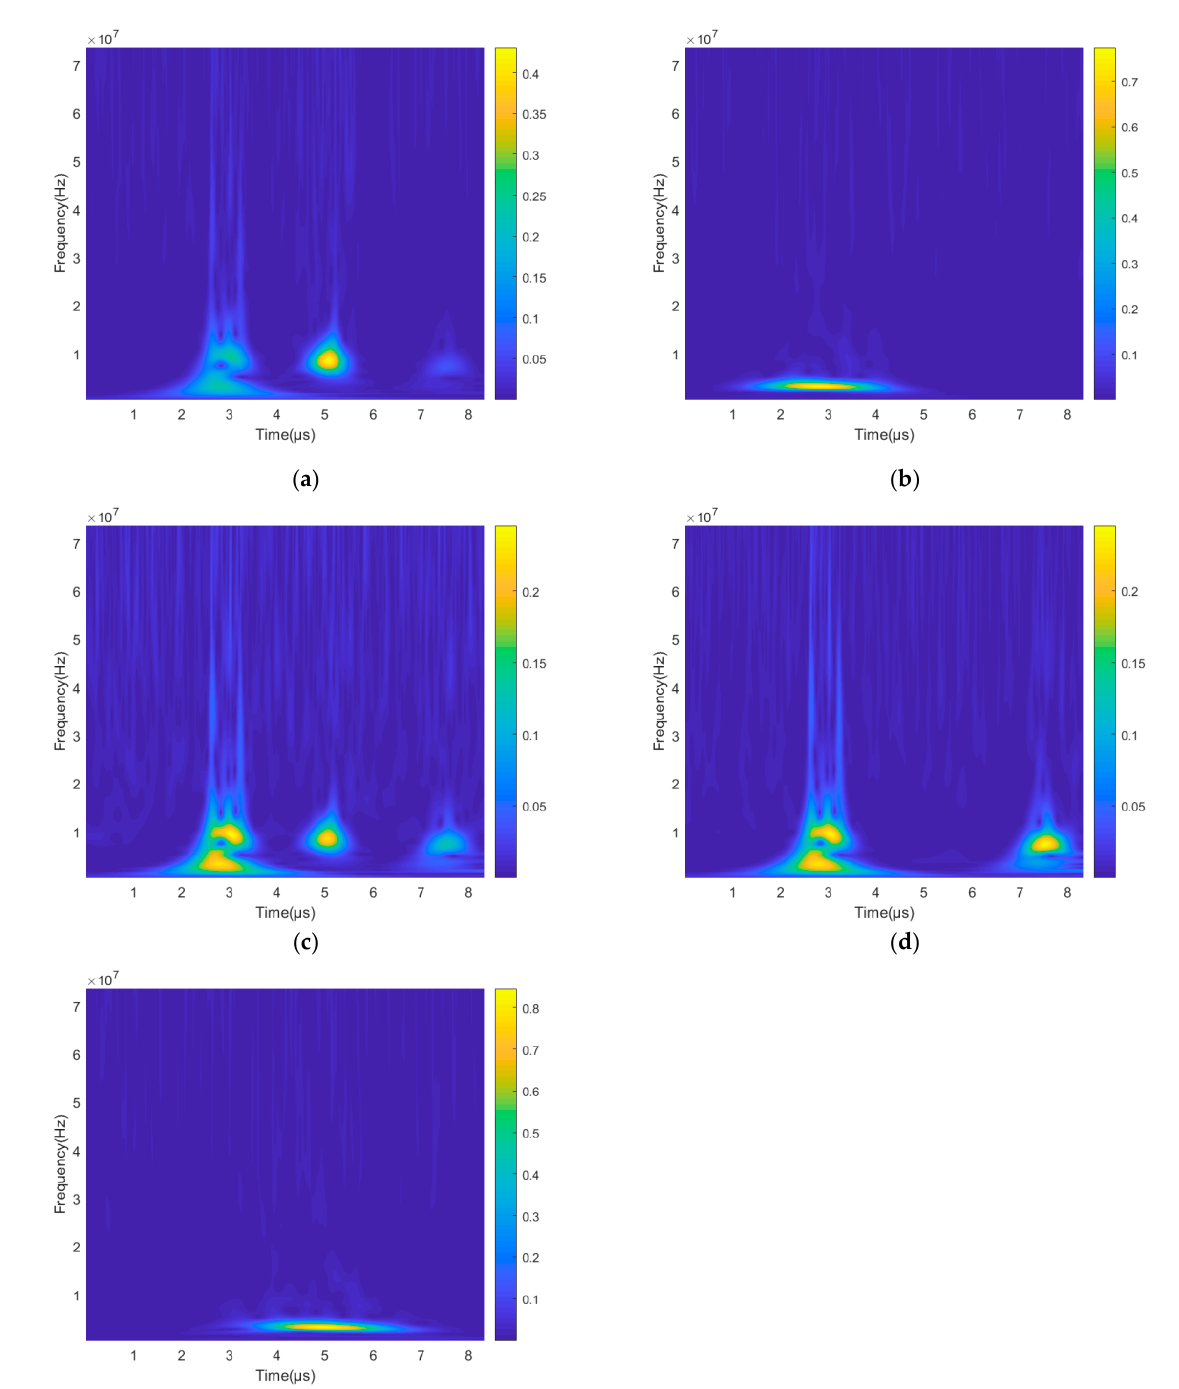
Figure 10. The feature from the echo signal of ultrasonic testing. ( a ) Time–frequency distribution of cavity state; ( b ) Time– frequency distribution of crack state; ( c ) Time–frequency distribution of inclusion state; ( d ) Time–frequency distribution of longitudinal normal state; ( e ) Time–frequency distribution of surface normal state.